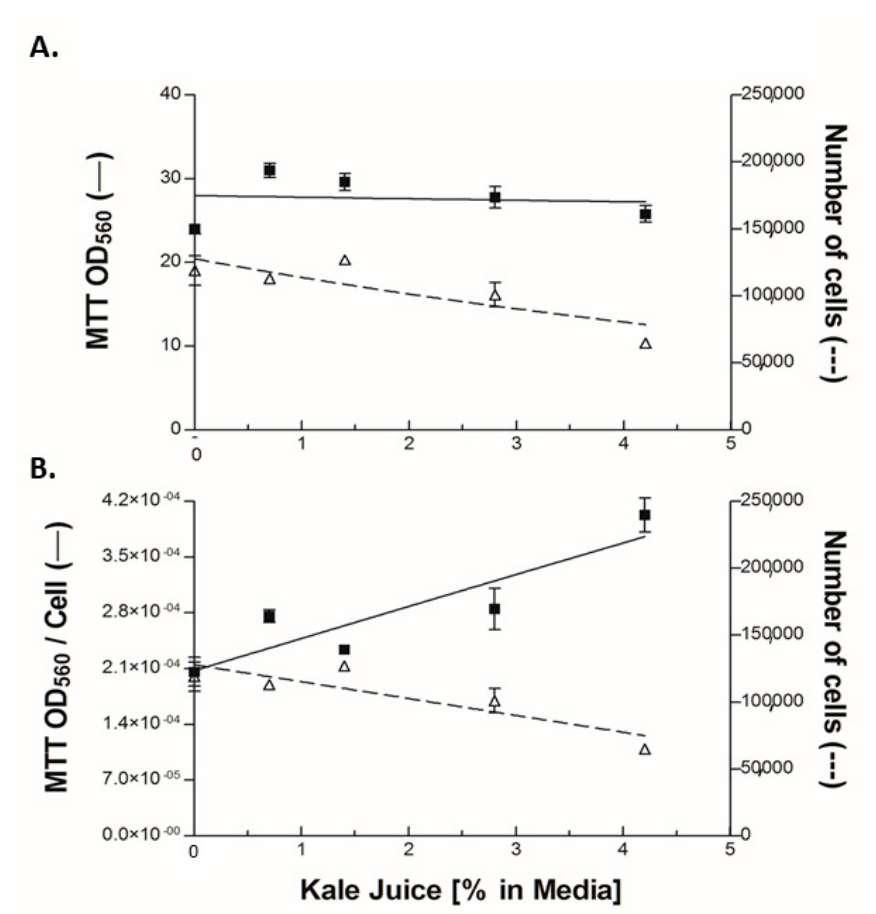
Figure 4. Dose response effects of apical kale juice on SH-SY5Y cells in the co-culture model (following Scheme 2 and Figure 1) after 3 days comparing numbers of cells by cellometry vs. reduction of MTT metabolic dye marker. All wells had equal numbers of cells when making kale juice dilutions (or adding equal volume vehicle). Three days later, panels ( A ) and ( B ) contrast the results expressed in panel A as MTT per well (left Y-axis) or expressed in panel B as MTT per cells in the well (left Y-axis). Points represent mean values ± SEM ( n = 4–5 experiments per condition) and the lines were drawn by linear regression in GraphPad Prizm